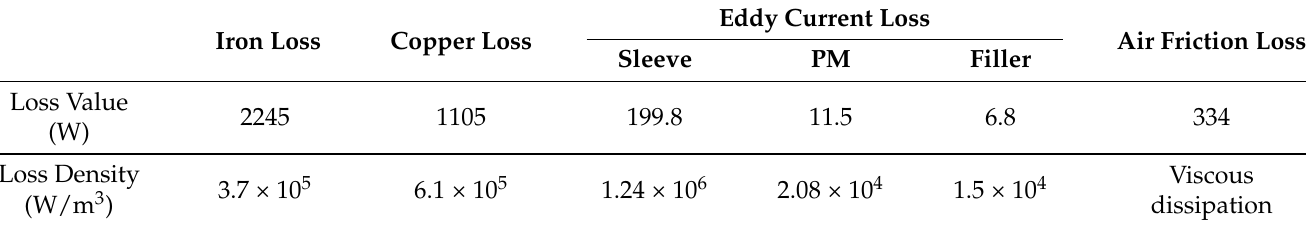
Table 6. The loss and loss density of the prototype in rated state.